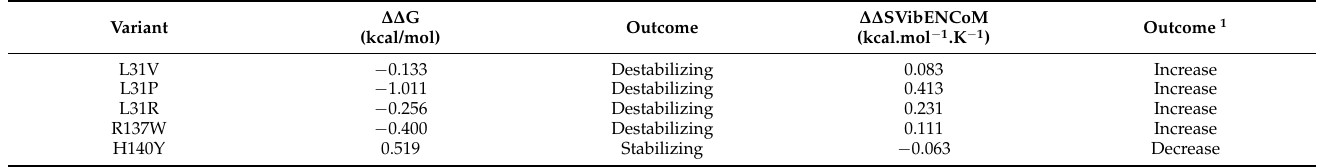
Table 3. Conformational Analysis of Protein’s Stability Change upon Amino Acid